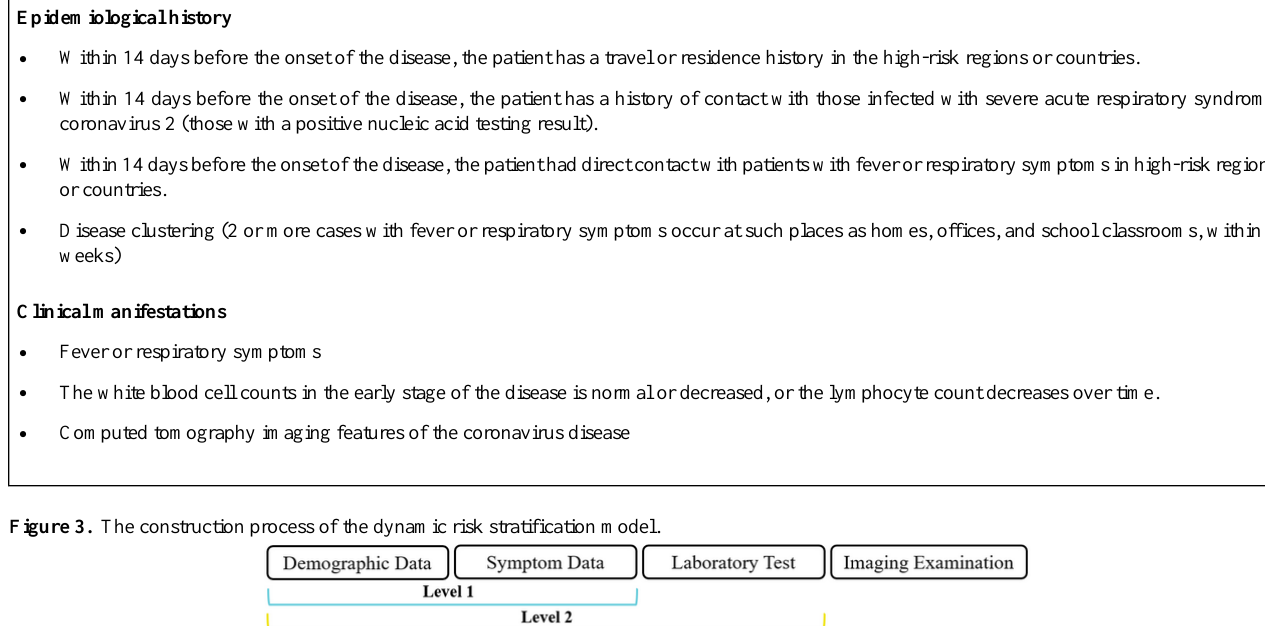
Figure 3. The construction process of the dynamic risk stratification model.